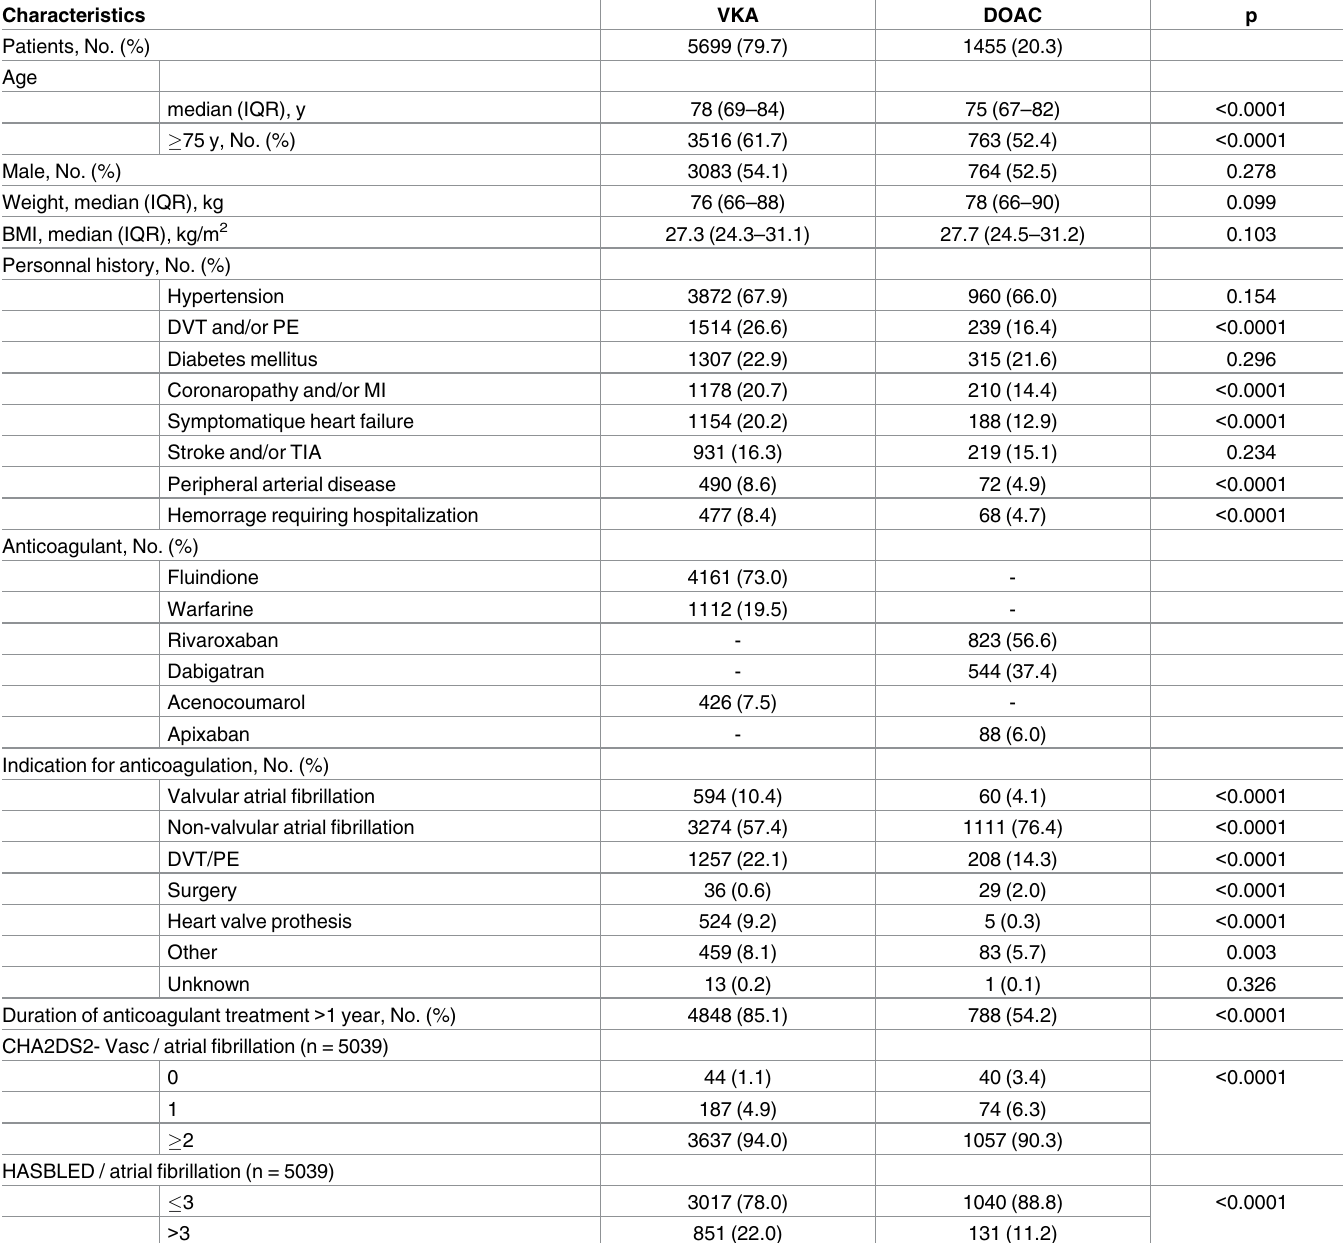
Table 1. Characteristics of